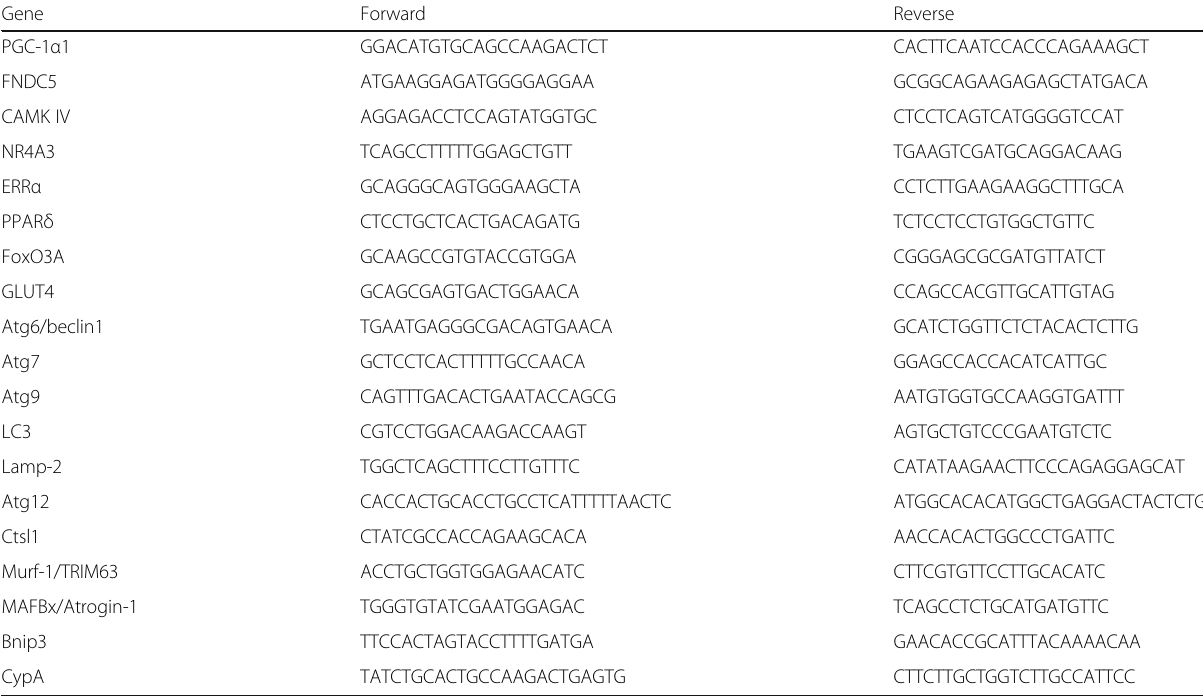
Table 1 Primer pairs used in real-time PCR